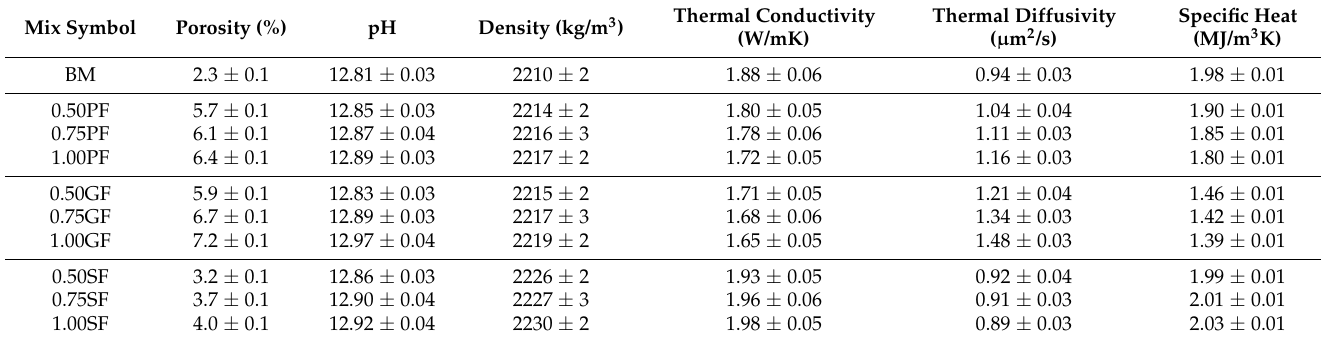
Table 6. Experimental results of material and thermal properties (average values).